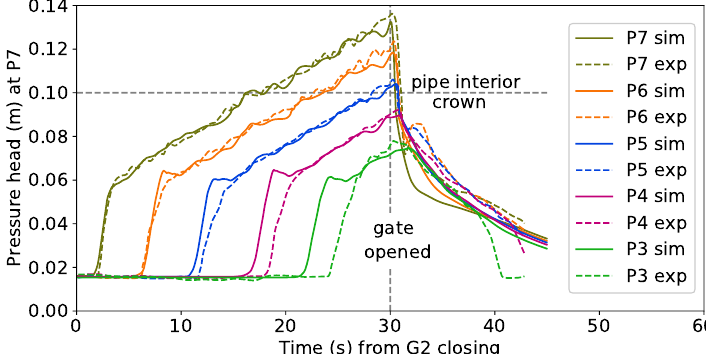
Figure 5. Pressure head at at sensors along the pipe length for Case